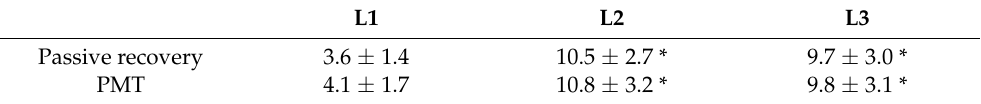
Table 2. Blood lactate results in the three different moments (mean ±